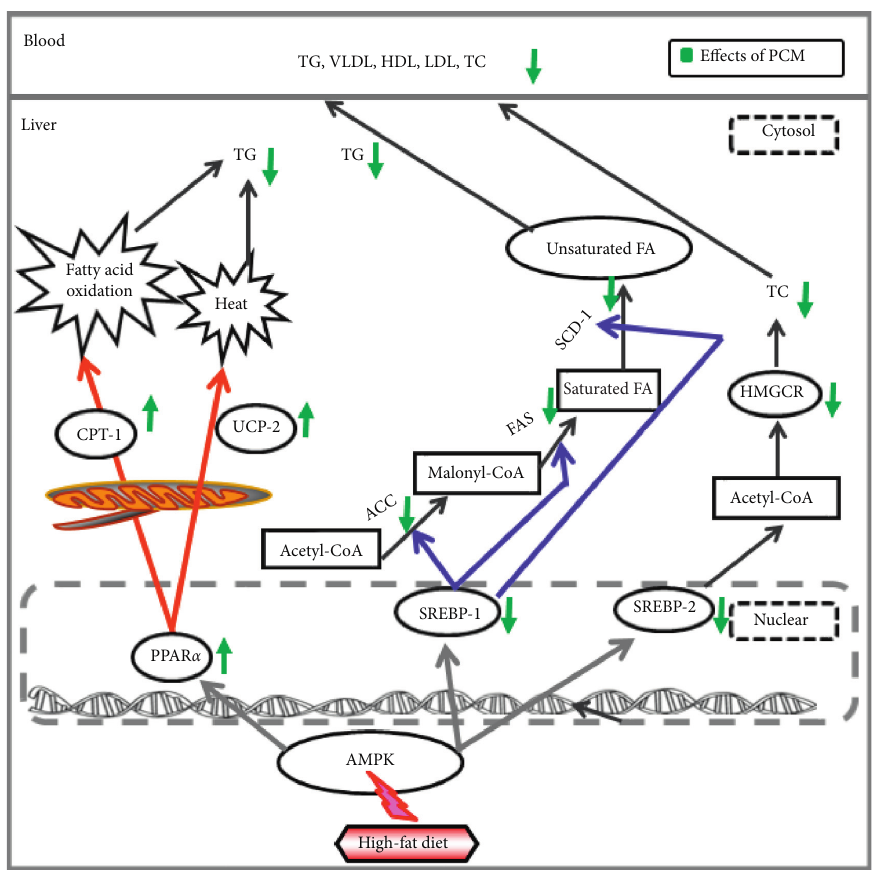
Figure 7: Predicted mechanism in hepatic tissues on administering